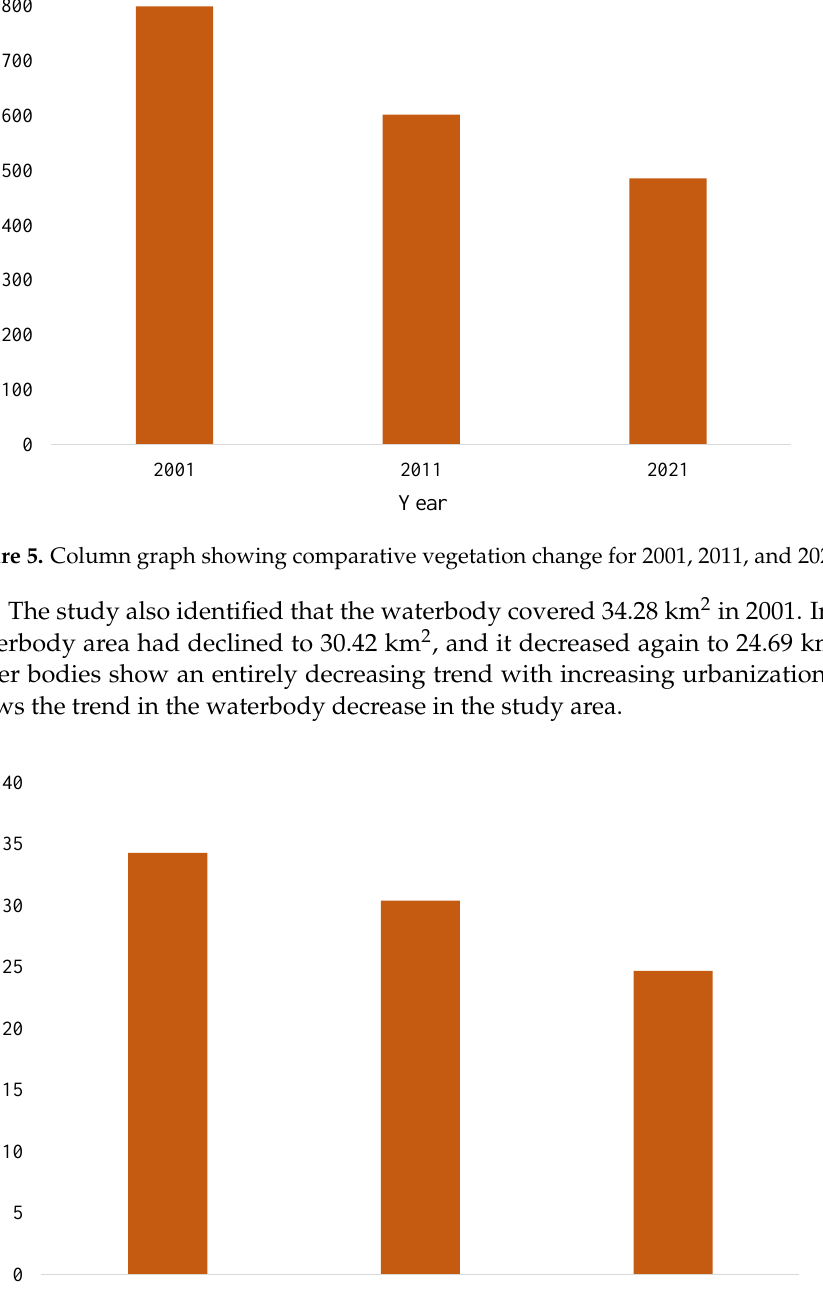
Figure 4. Column graph showing comparative vegetation change for 2001, 2011, and 2021.